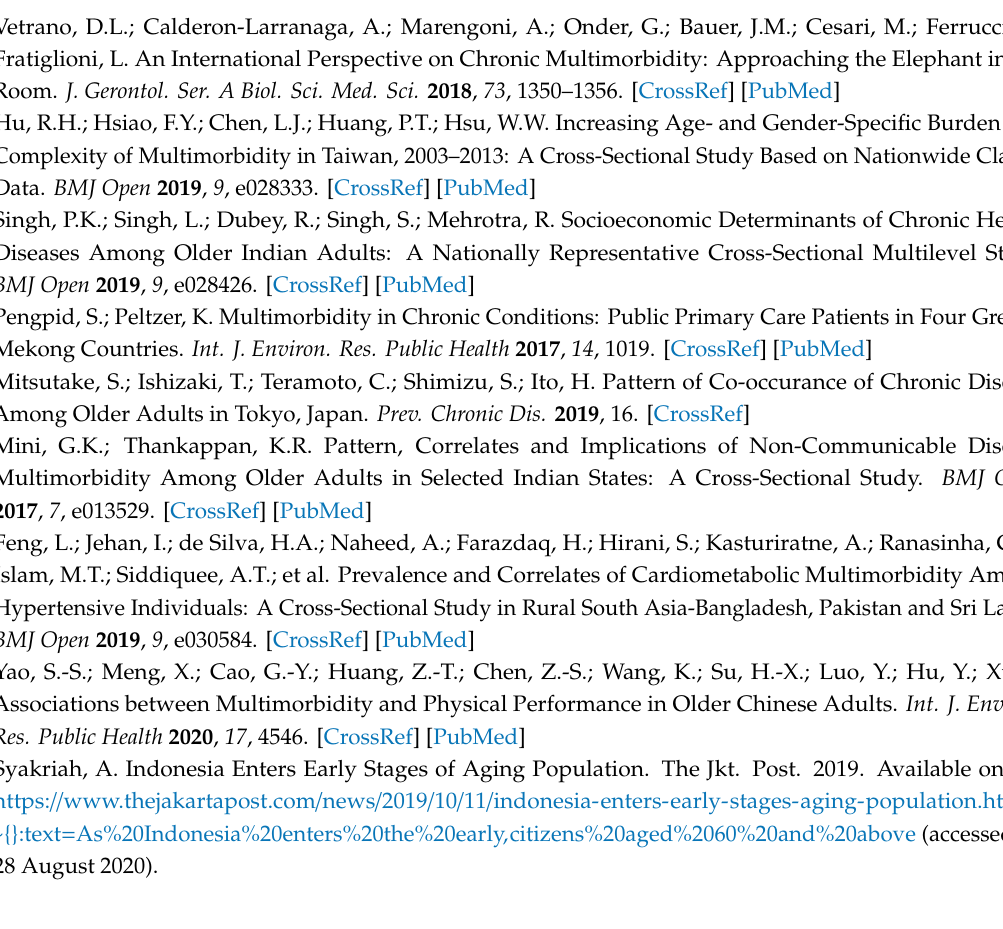
Table S1: List of chronic conditions included in the